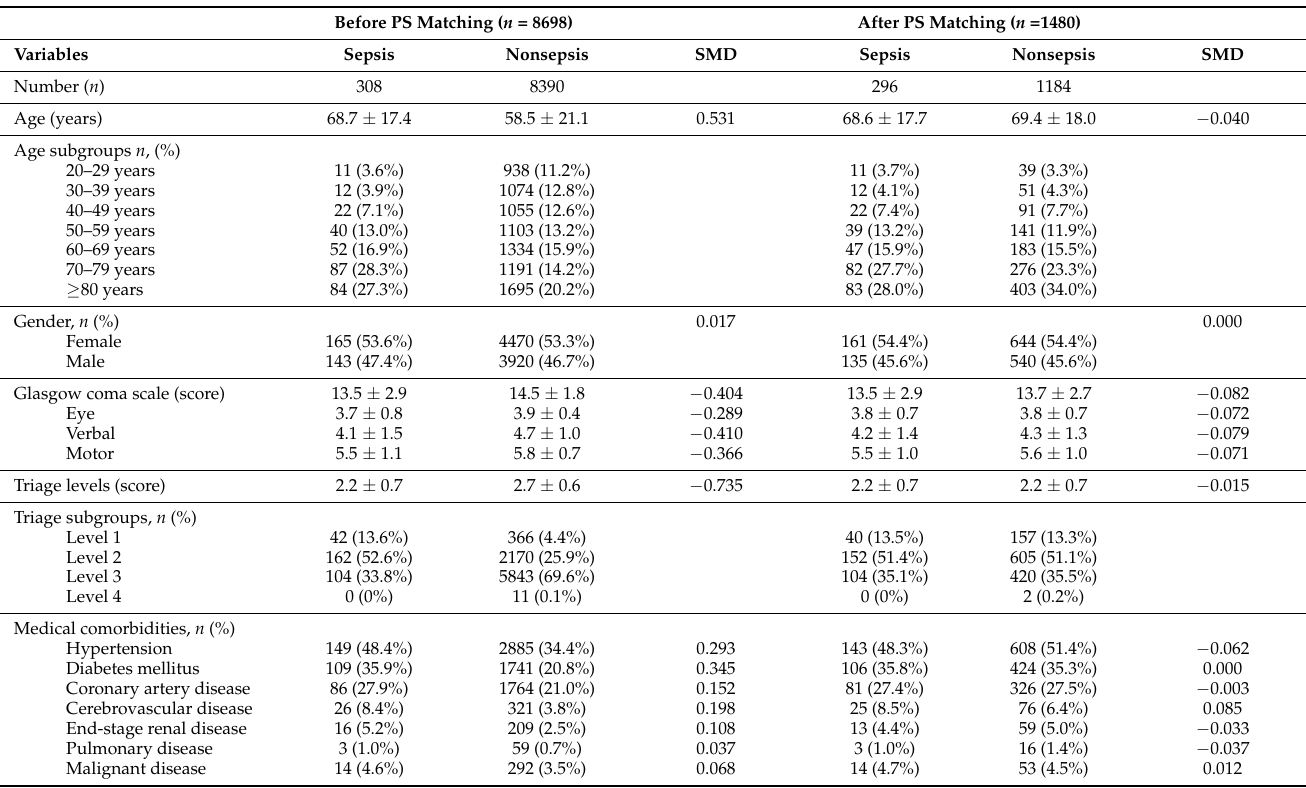
Table 1. Characteristics of Enrolled Patients.